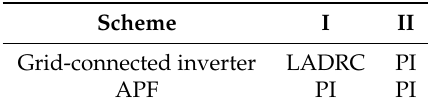
Table 2. Control strategy for different scheme.